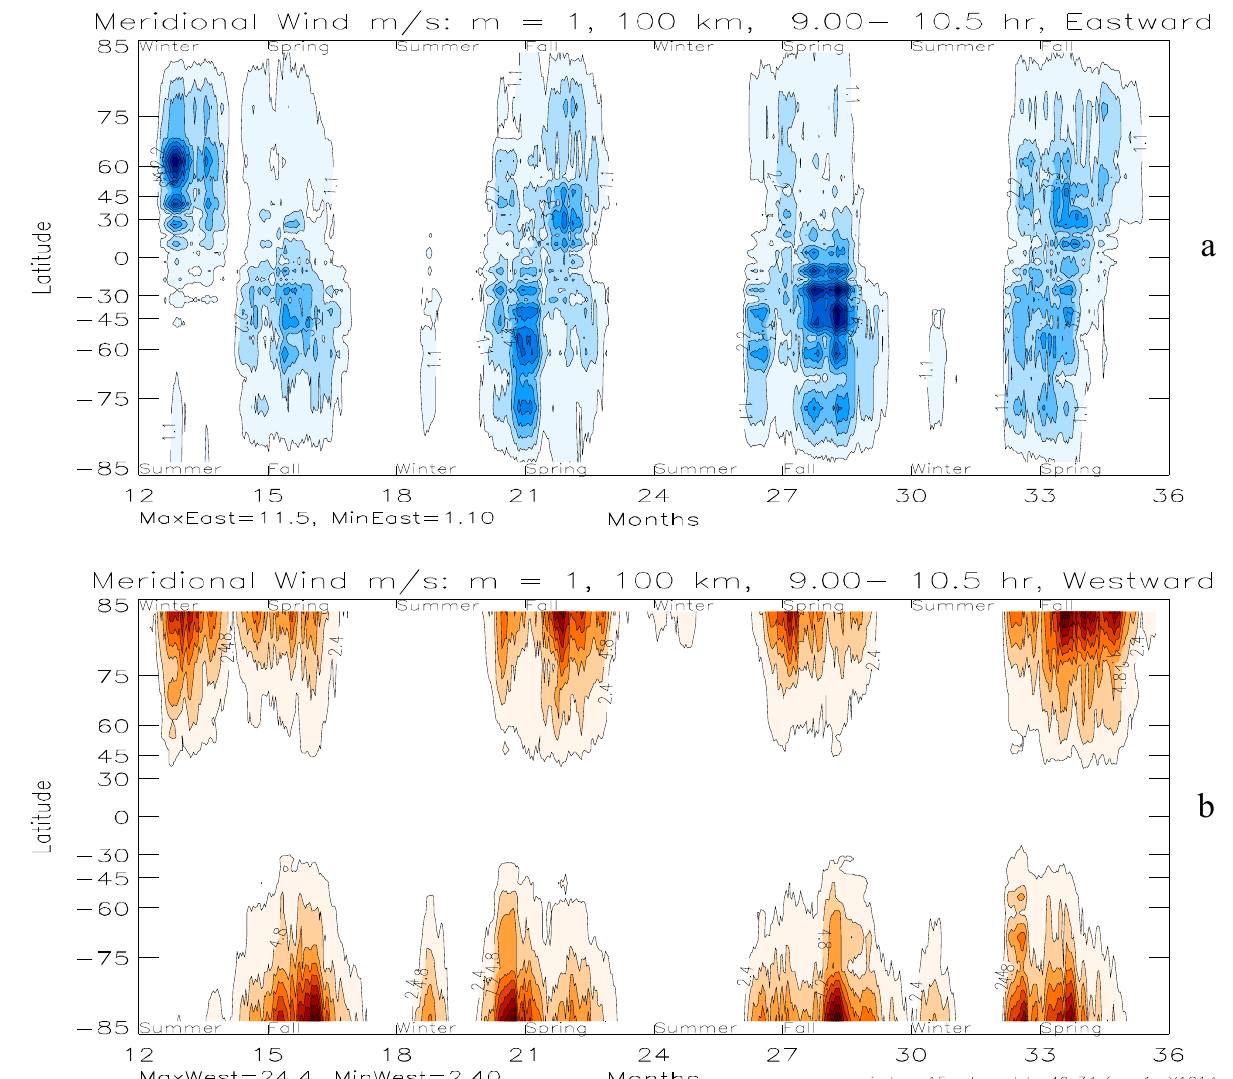
Fig. 10. Similar to Fig. 8 but computed without excitation of the migrating diurnal and semidiurnal